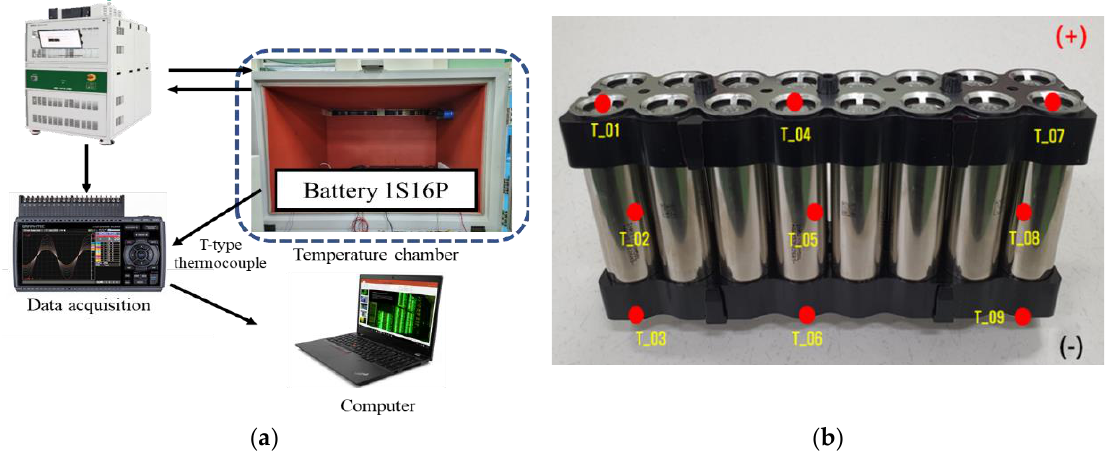
Figure 4. Verification experimental setup: ( a ) Schematic diagram of experimental setup; ( b ) 1S16P battery module.